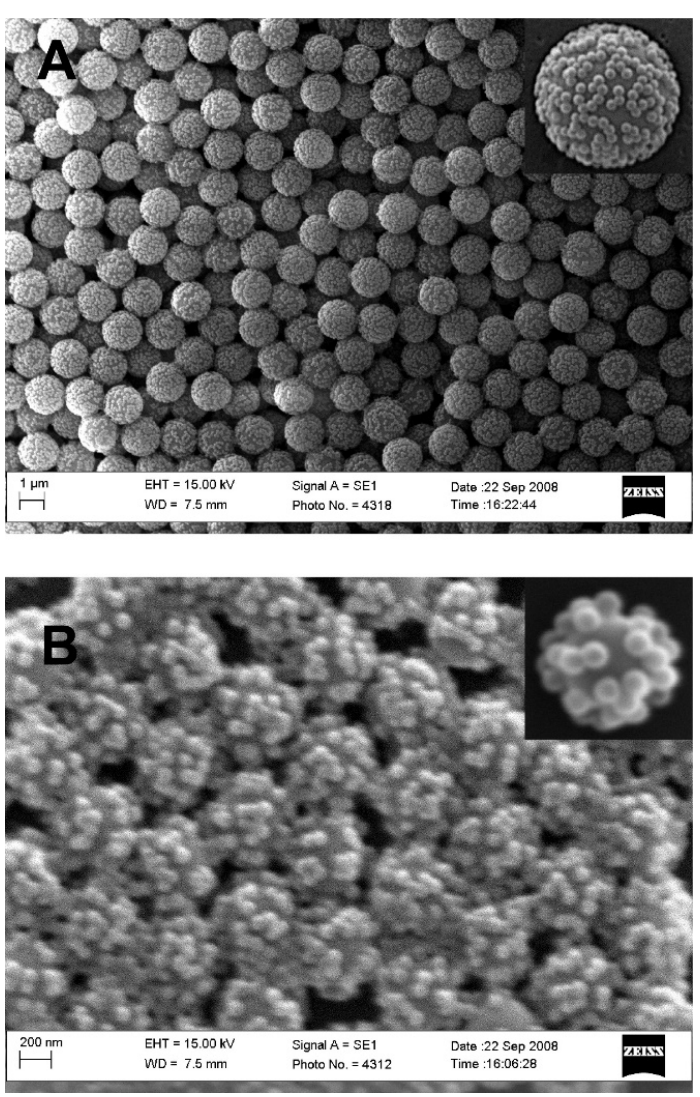
Figure 5. SEM images showing raspberry-like hierarchical templates prepared via coupling PS- COOH spheres with PH-NH 2 . Templates with ( A ) 1500/110 nm and ( B ) 450/80 nm core/satellite were prepared (reproduced with permission from [41], copyright 2010 American Chemical Society).